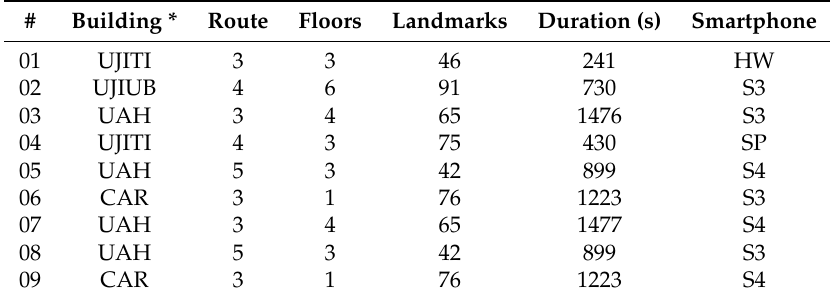
Table 2. Description of the evaluation